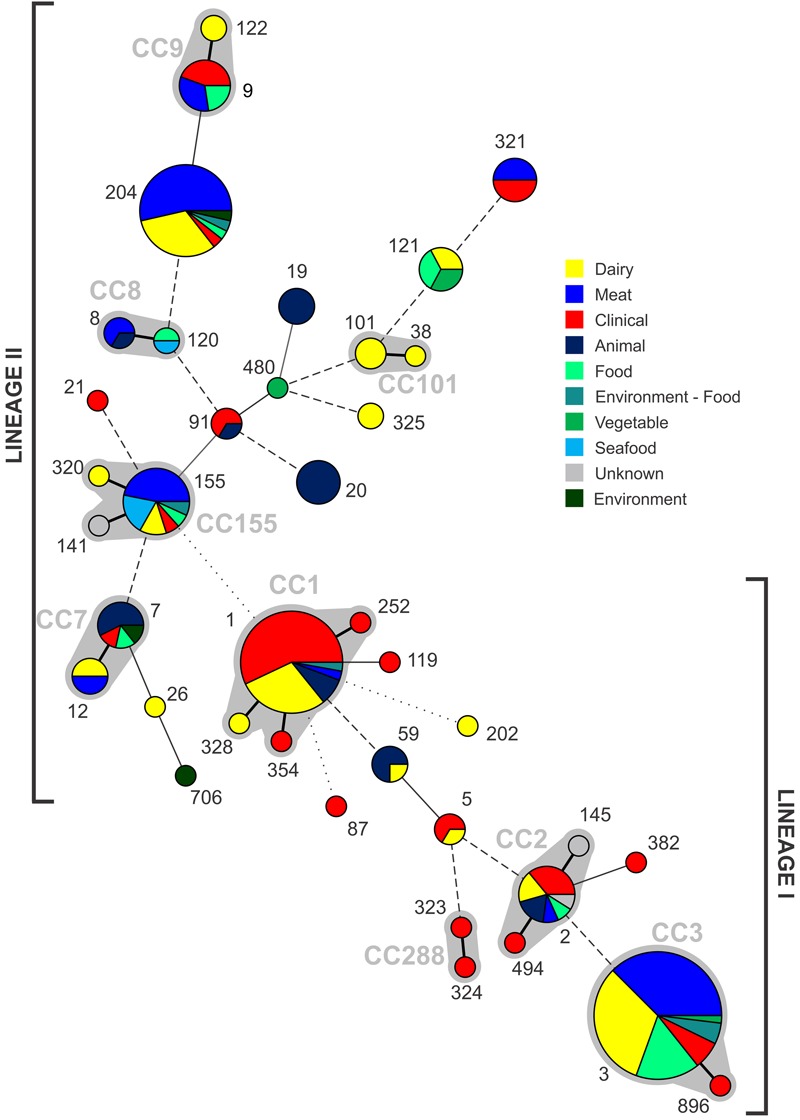
Distribution of STs identified from each source, with increasing circle size representing a larger number of isolates of that ST. Clonal complexes are partitioned (gray shading, and indicated by gray text). Connecting lines infer phylogenetic relatedness in terms of number of allelic differences (thick solid, 1; thin solid in partition, 2; thin solid outside partition, 3; broken, 4–6; dotted, no allelic matches). ST202 is lineage III.